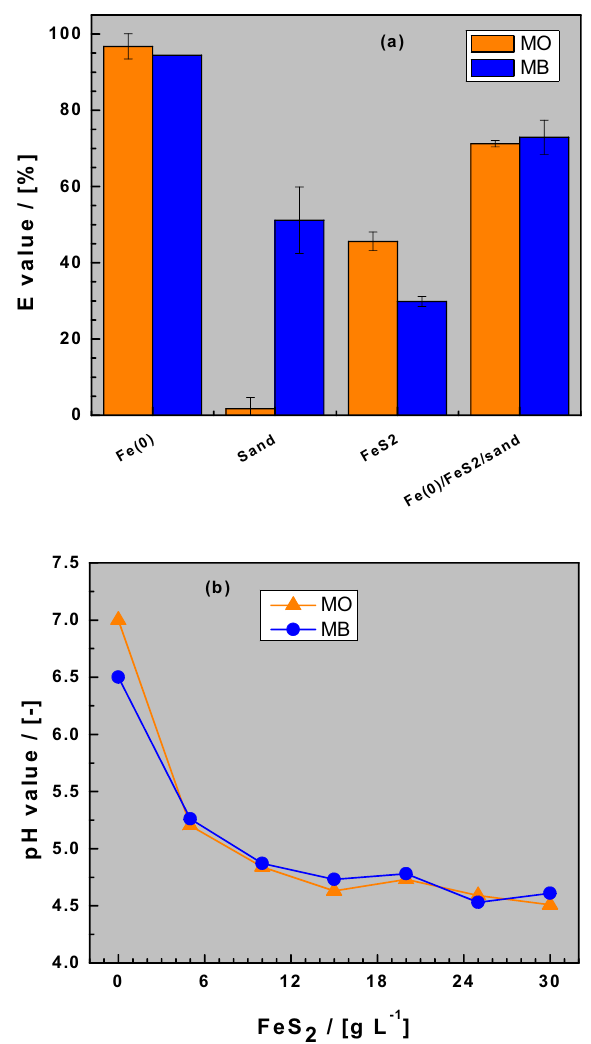
Figure 1. Changes of the dye discoloration efficiency (E values) in single-aggregate and ternary system ( a ) and changes of final pH value as a function of the FeS 2 dose ( b ). Experimental conditions: V = 20 mL, m iron = 0.0 or 0.1 g, m sand = 0.0 or 0.5 g, m pyrite 0 to 0.6 g, and t = 41 d. The lines are not fitting functions, they simply connect points to facilitate visualization.